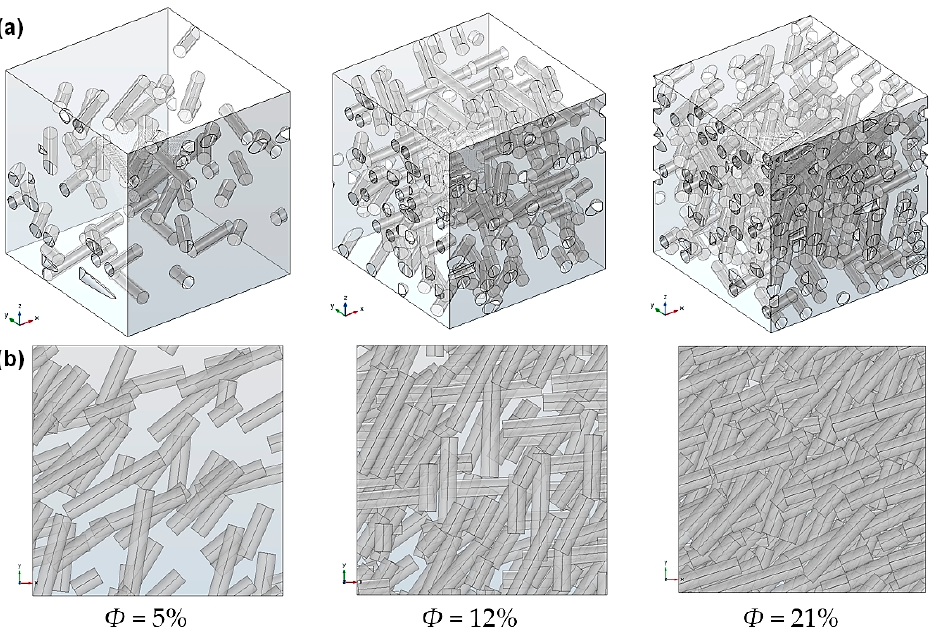
Figure 7. View of generated RVEs with polydisperse uniform dispersions for several volume fraction values (average aspect ratio α = 4.3): ( a ) isometric view; ( b ) projected view in the overall diffusion direction z.